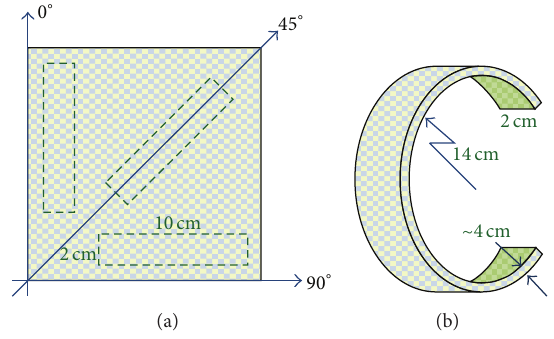
Figure 4: The fiberglass composites: (a) the definition of the cutting directions and the size of the strip samples. (b) The size of the curved beam sample.